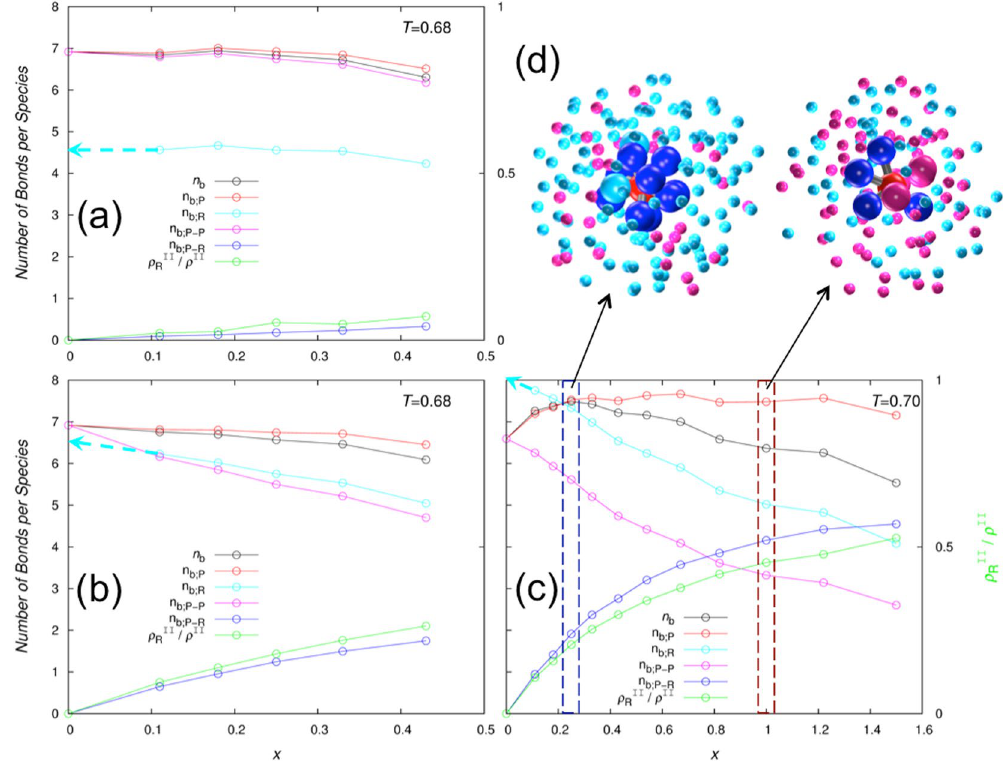
Figure 5. The average number of bonds per particle in the droplet phase and its decomposition by species. ( a – c ) displays bond information (left ordinate axis) and molar fraction of R particles in the droplet phase, ρ ρ / RII II , (right ordinate axis) at ε PR = 0.5, 1.0, and 1.35, respectively, for the temperatures indicated. ( d ) Illustration of bonding networks in the droplet phase at ε PR = 1.35, where R particles strengthen bonding at small X (left, X = 0.25) but disrupt bonding at large X (left, X = 1.0). In the central cluster, an R particle and its bonded P neighbors (9 in the left and 4 in the right) are shown as full-size spheres in red and blue, respectively, with bonds in gray; nonbonded P and R neighbors (2 Ps in the left and 4 Rs in the right) are shown as full-size spheres in cyan and magenta, respectively. The latter coloring scheme is also used for the more distant P and R particles, shown with radius reduced to